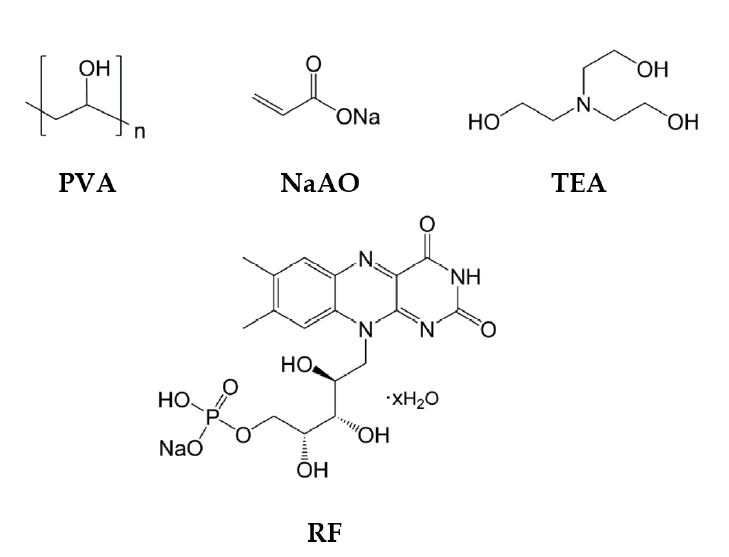
Figure 1. Biophotopol chemical structures of the prepolymer components. PVA: polyvinyl alcohol, NaAO: sodium acrylate, TEA: triethanolamine, RF: riboflavin 5’- monophosphate sodium salt.